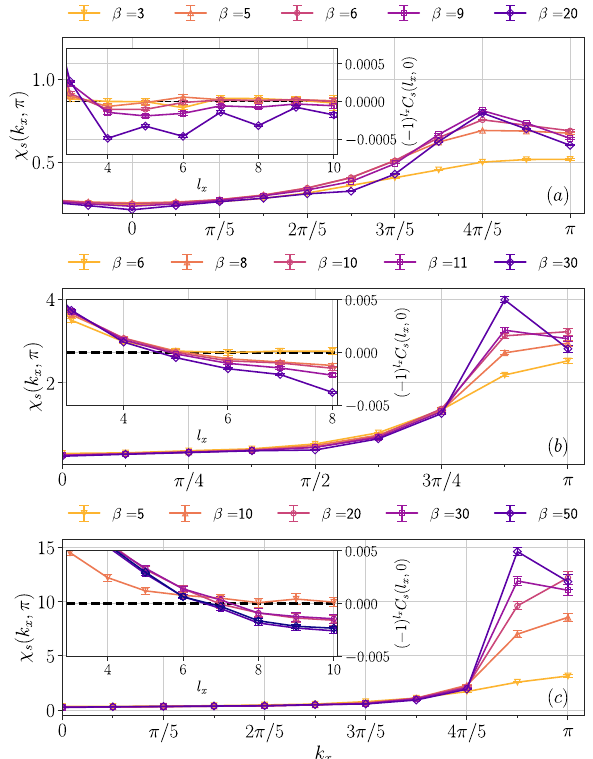
FIG. 3. Quantitative characterization of the spin susceptibility χ k Þ and real-space correlation function C s ð systems in Fig. 2: (a) δ ¼ 1 = 5 , U ¼ 6 , (b) δ ¼ 1 = 8 , U ¼ 8 , and (c) δ ¼ 1 = 10 , U ¼ 8 . The main figure in each shows χ s ð k x ; π Þ versus momentum k x , while the inset shows line cuts of the staggered spin correlation function ð − 1 Þ l x C s ð l x ; 0 Þ along a specific row with l y ¼ 0 . For each system, results for five selected temperatures are